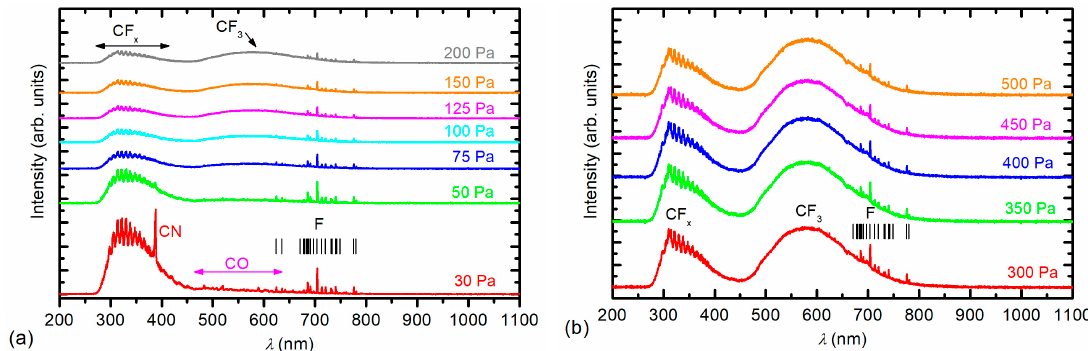
Figure 9. OES spectra of CF 4 plasma at various pressures: ( a ) below the threshold pressure and ( b ) above the threshold pressure.